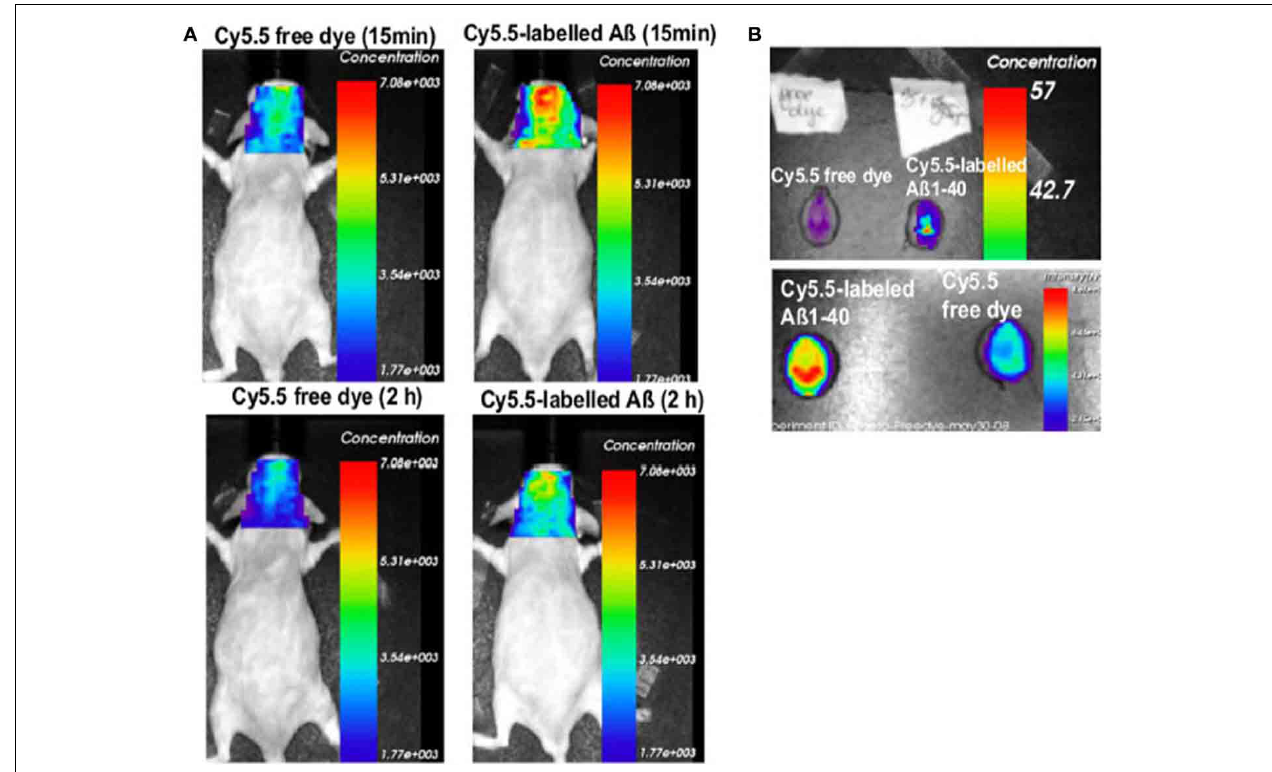
FIGURE 4 | Absence of Abcg2 allows more A β peptides to be transported into the brain. (A) Two pairs of Abcg2 knockout mice were injected i.v. Cy5.5-free dye or Cy5.5-labeled A β 1 − 40 peptides in equal fluorescence intensity. Animals were scanned alive using a NIRF imager at 15min and 2h. (B) NIRF scans of ex vivo brains collected at the end of the experiment. Signal intensity was significantly higher in the brains of